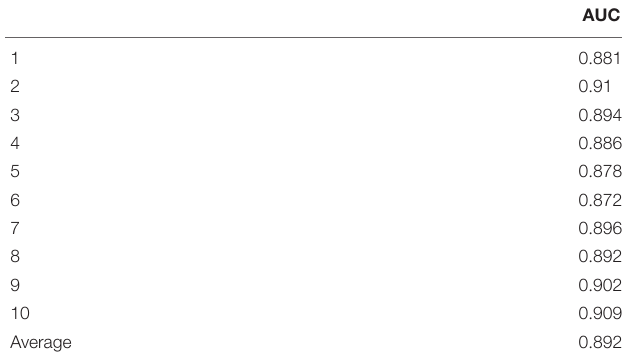
TABLE 1 | Area under the curve of 10-fold cross-validation.